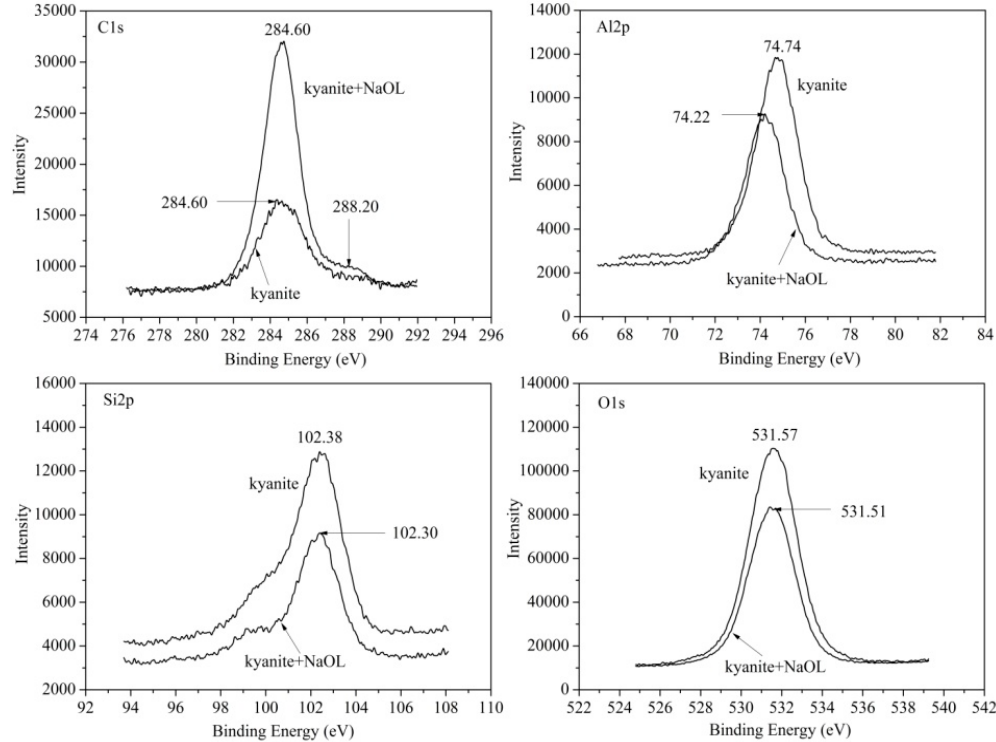
Figure 9. XPS high-resolution spectra of C1s, Al2p, Si2p and O1s on kyanite in the absence and presence of sodium oleate (NaOL).